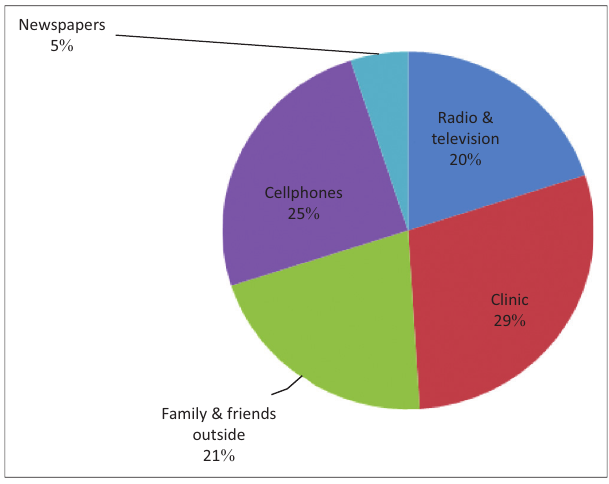
FIGURE 3: Sources of early-warning